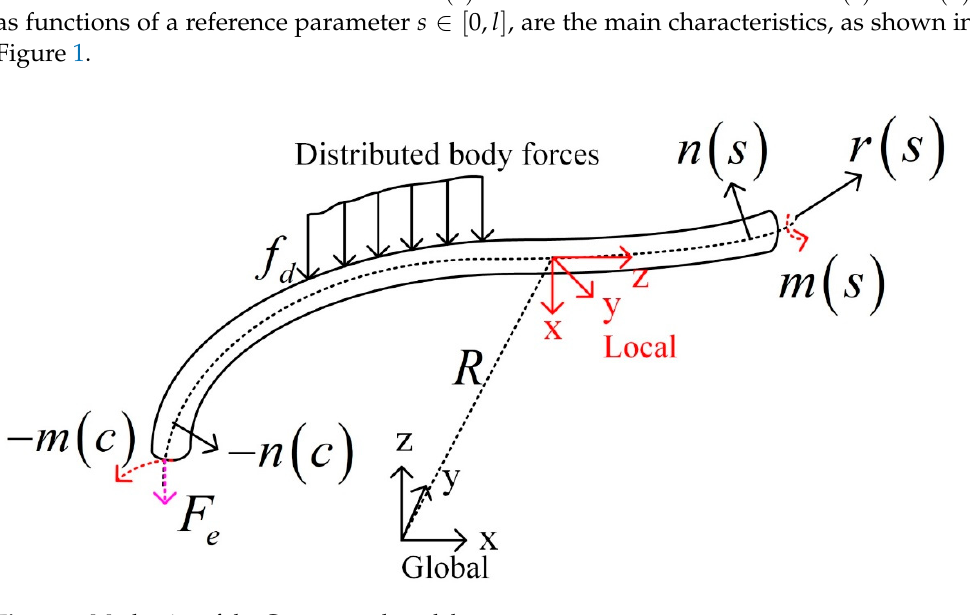
Figure 1. Mechanics of the Cosserat rod model.